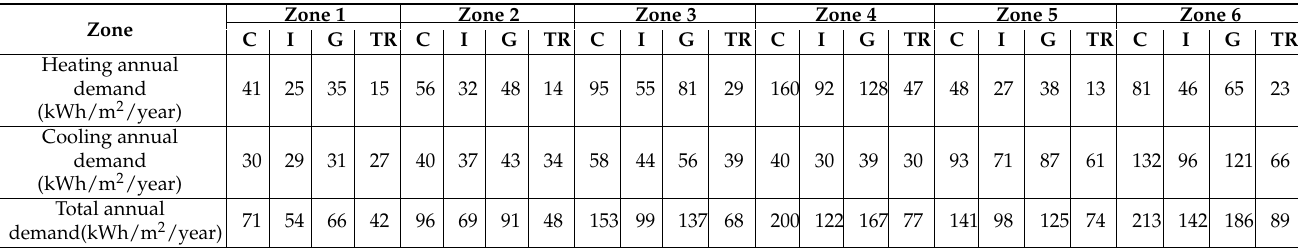
Table 9. Heating and cooling annual